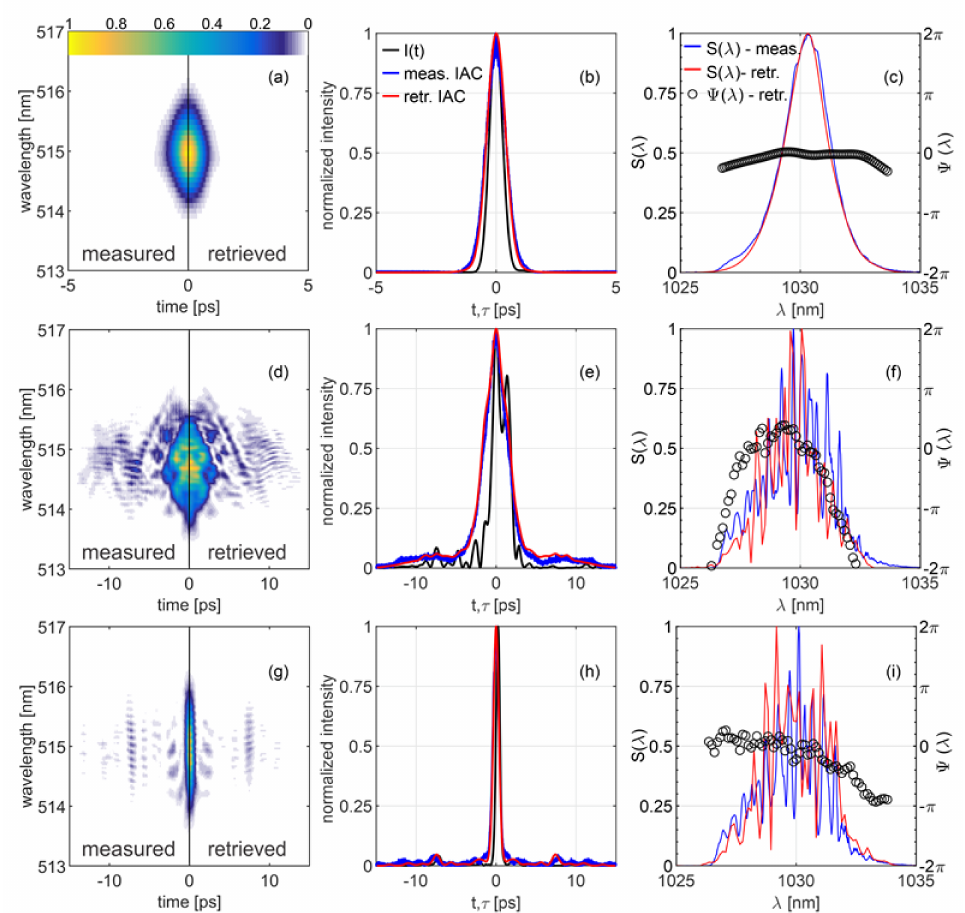
Figure 3. FROG measurement of the pulse with 50 µ J energy at 100 kHz pulse repetition rate (top ( a – c )) and 2 MHz pulse repetition rate (center ( d – f )). Both top and center measurements are performed with the reference state settings of the TCFBG. The measurement at 2 MHz pulse repetition rate but with adjusted TCFBG dispersion parameters in order to compensate for accumulated nonlinear phase is presented at the bottom ( g – i ). Subfigures show measured (left) and retrieved FROG trace ( a , d , g ); measured and retrieved autocorrelation and retrieved pulse intensity ( b , e , h ); and measured and retrieved pulse spectrum with retrieved spectral phase ( c , f , i